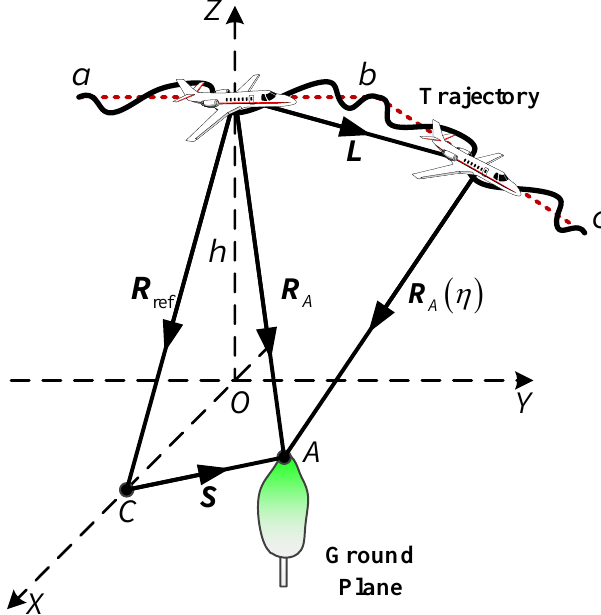
Figure 3. 3-D geometry model of CLSAR.